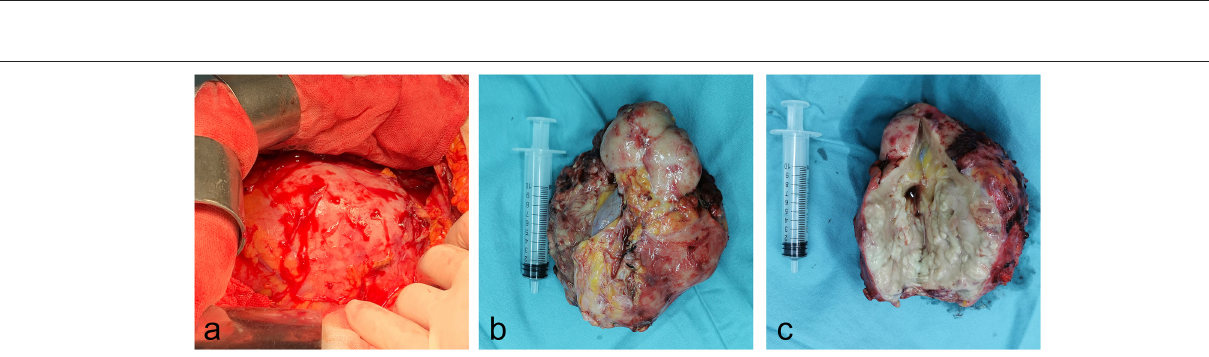
FIGURE 5 | Gross photos of specimens during and after operation. (a) The left kidney swelling increased significantly during the surgery. (b,c) The overall appearance and tissue section of the left kidney specimens cut during